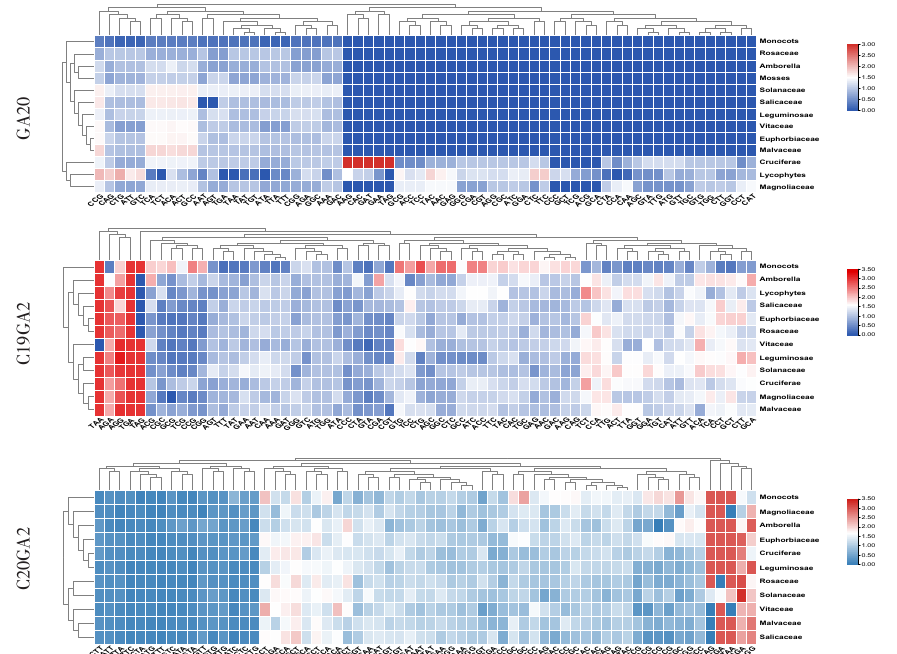
Figure 7. Relative synonymous codon usage (RSCU) of GA20ox , C19GA2ox , and C20GA2ox gene families in all 21 species. Blue-to-red color indicates low to high RSCU values of